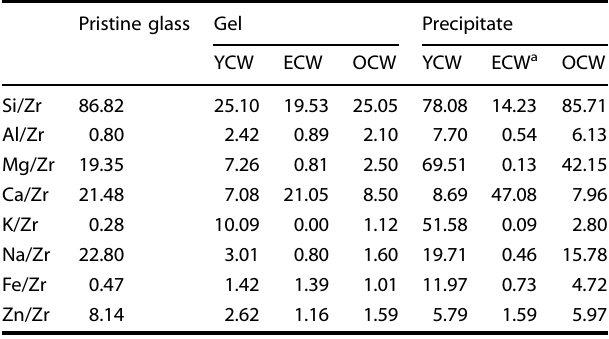
Table 3. Average Zr-normalised atomic ratios of major elements in the pristine glass, the gel layer and the secondary precipitates, as determined by